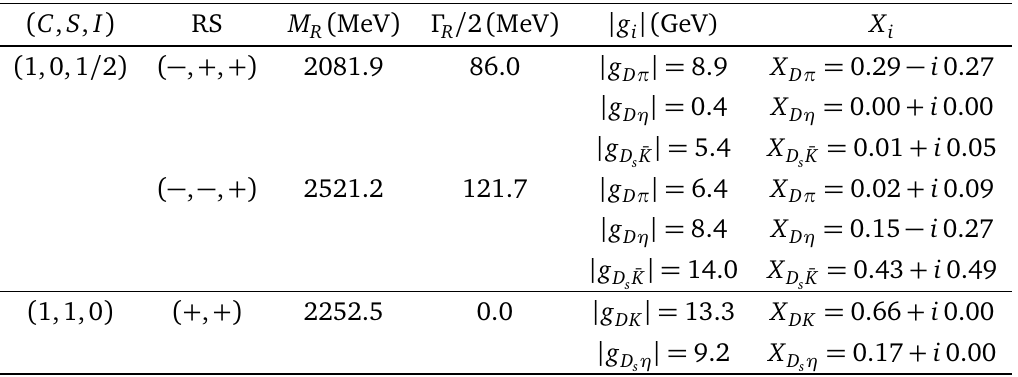
Table 1: Poles and the corresponding couplings and compositeness for the coupled channels in the sectors with the quantum numbers of the D ∗ ( 2317 ) ± (lower). the D ∗ s 0